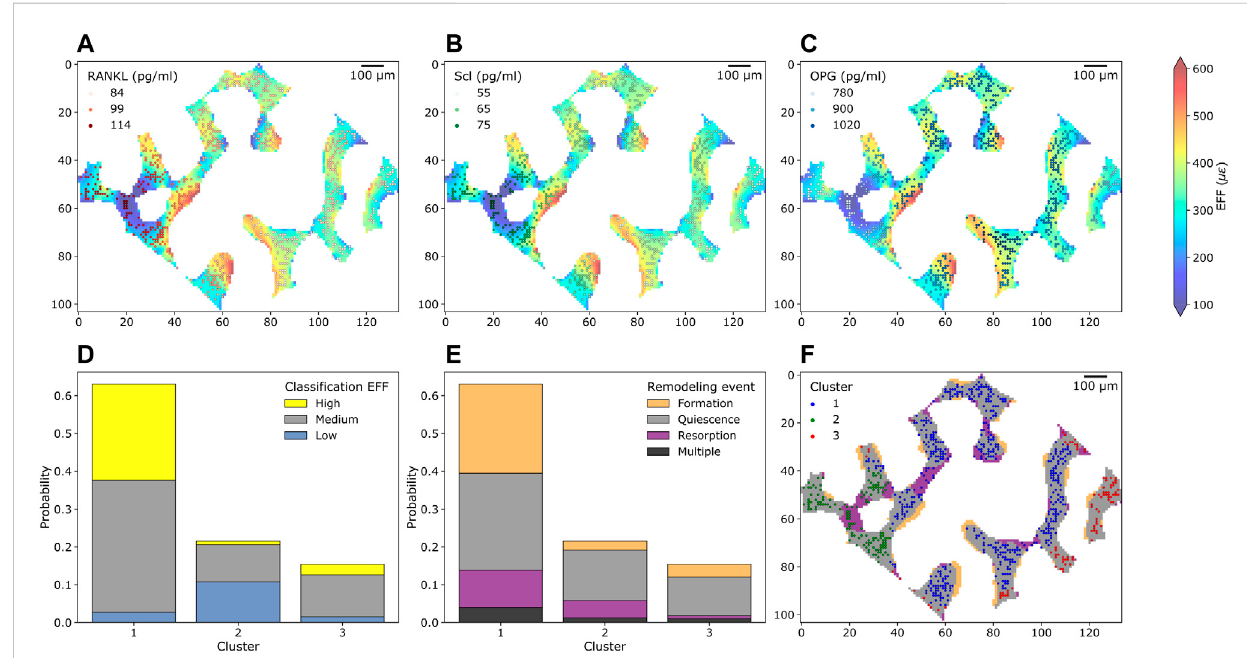
FIGURE 3 Cross-section of trabecular bone with osteocytes and their protein levels, mechanical environment and bone remodeling from the simulation of homeostatic bone remodeling using single-cell mechanomics. (A) (B) , and (C) show trabecular bone colored with the mechanical signal (EFF = effective strain)andosteocytes(asdots, n =748)withReceptoractivatorofnuclearfactor κβ ligand, sclerostin(Scl)andosteoprotegerin(OPG)levels,respectively. RANKL,SclandOPGareshowninshadesofreds,greensandblues,respectively. (D) Absolute frequencyoflevelsofmechanicalsignalinthesection dividedpercluster.Yellow=highlabel,gray=mediumlabel,lightblue=lowlabel. (E) Absolutefrequencyofclosestboneremodelingevents(Formation, Quiescence, Resorption or Multiple if more than an event is closest) to the osteocytes in the section divided per cluster. (F) K-means clustering of osteocytes and bone remodeling in the